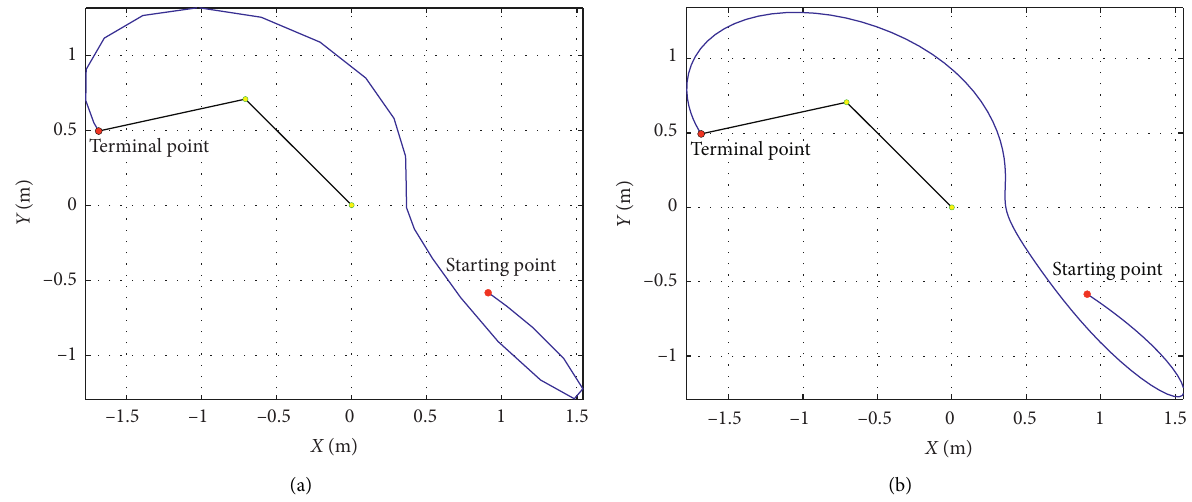
Figure 7: The trajectory of 2-DOF robotic manipulator in case 1. (a) Conventional B-spline optimization. (b) Improved B-spline optimization.